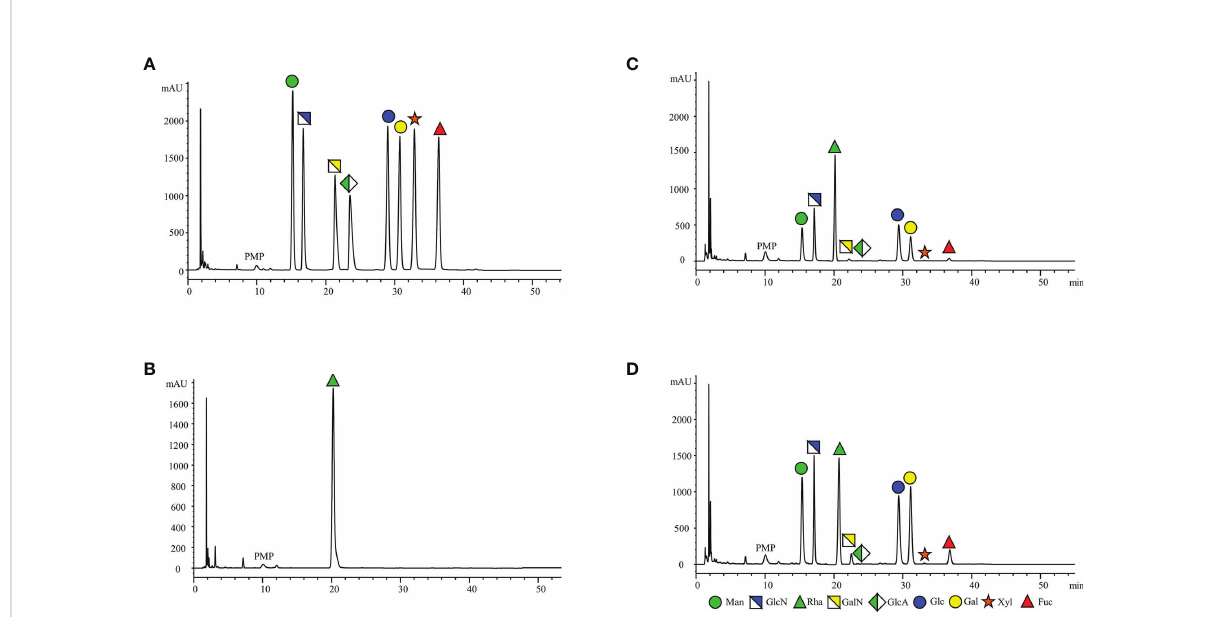
FIGURE 2 Representative HPLC chromatograms of PMP-labeled monosaccharides. (A) monosaccharides standards (250 m g/mL); (B) Internal standard; (C) Healthy control and (D) EC patient serum sample with the internal standard. (1) Man (RT: 15.37 ± 0.05 min), (2) GlcN (RT: 17.15 ± 0.04 min), (3) Rha (RT: 20.32 ± 0.09 min), (4) GalN (RT: 22.08 ± 0.06 min), (5) GlcA (RT: 24.27 ± 0.05 min), (6) Glc (RT: 29.53 ± 0.06 min), (7) Gal (RT: 31.25 ± 0.07 min), (8) Xyl (RT: 33.33 ± 0.07 and min), (9) Fuc (RT: 36.83 ± 0.07